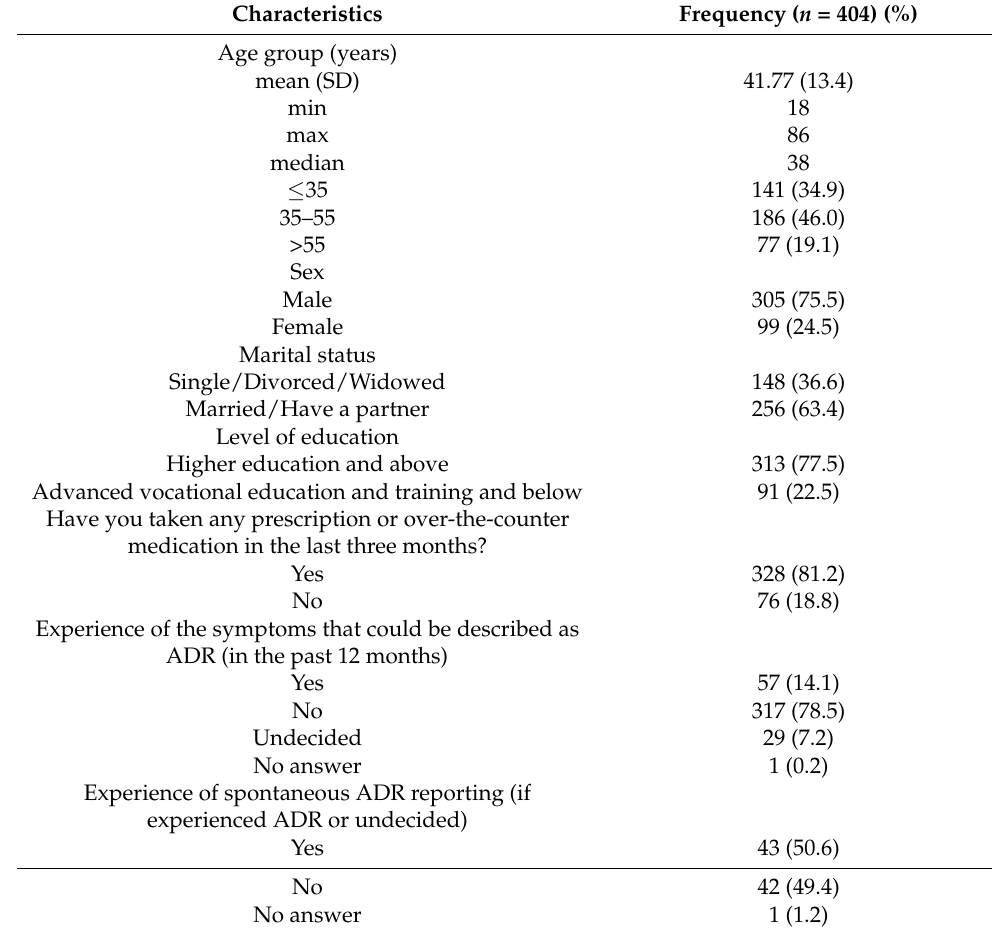
Table 1. Demographic characteristics and clinical background of the survey